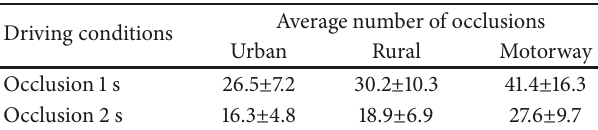
Table 1: Average number of occlusions per scenario and